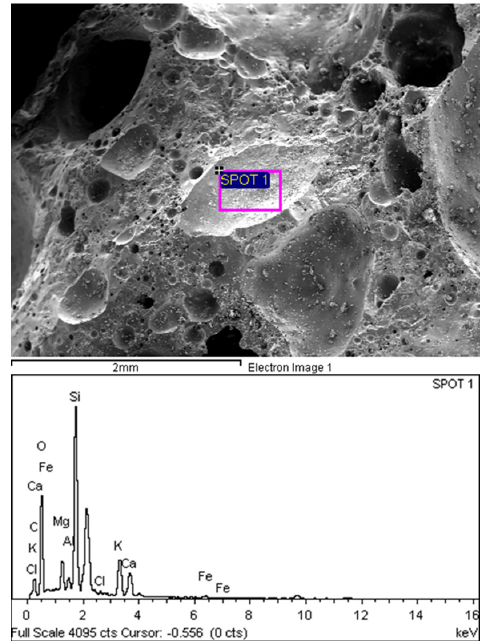
Figure 8. POC aggregate micrograph at a larger magnification.